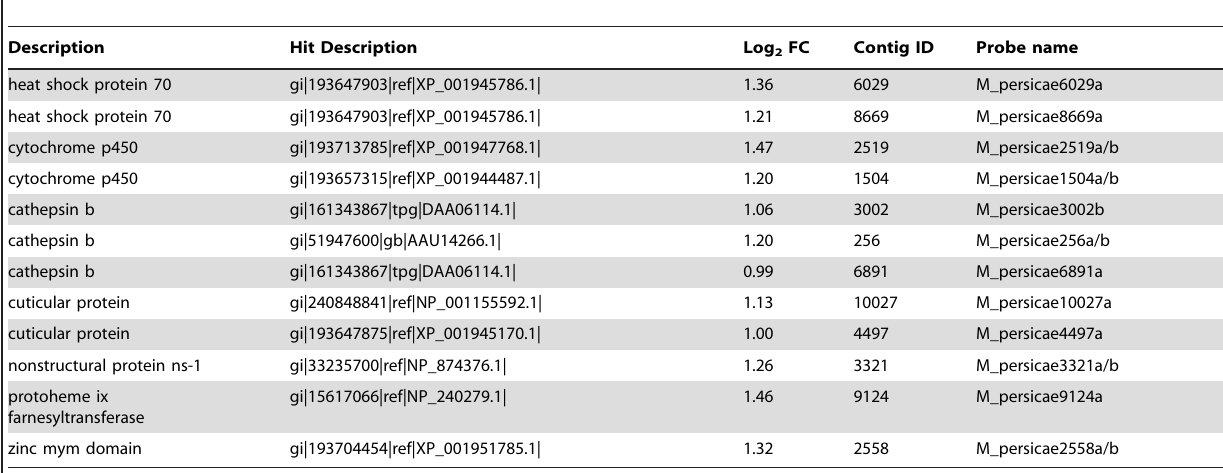
Table 3. Selected genes identified by microarray as significantly up-regulated in SR (simple resistant) genotype in response to